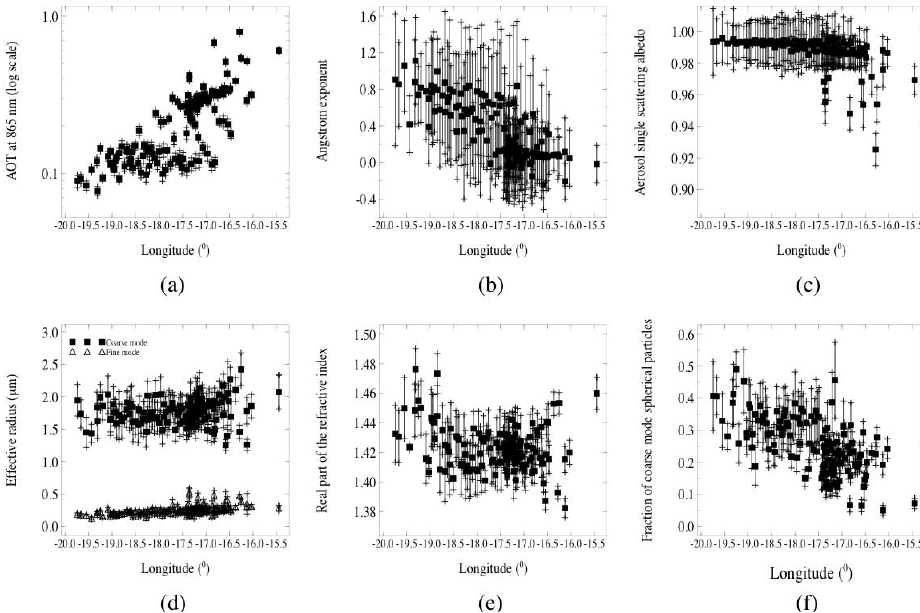
Fig. 4. Aerosol parameters (squares or triangles) and associated uncertainties (lines with crosses) retrieved on 7 May 2010, shown in function of longitude. The longitude increases as the distance to the volcanic plume decreases. The selected area is shown in Fig. 2 (black